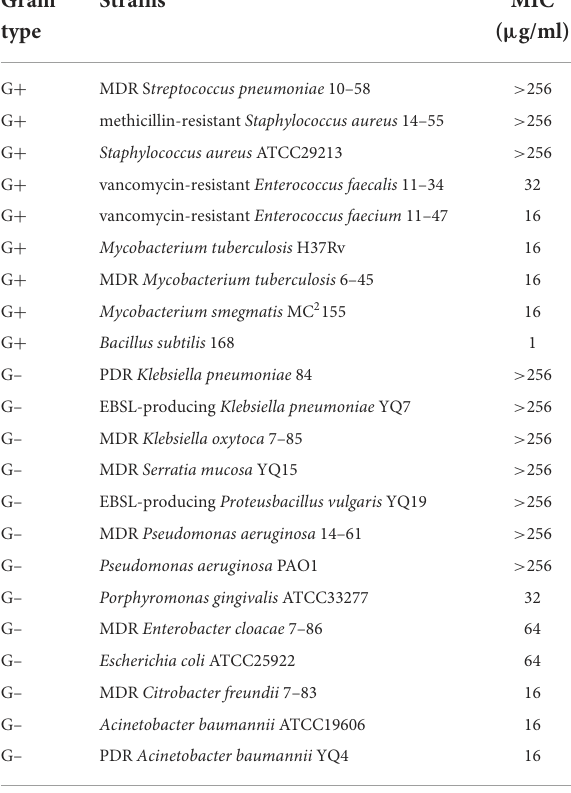
TABLE 1 The bactericidal spectrum of